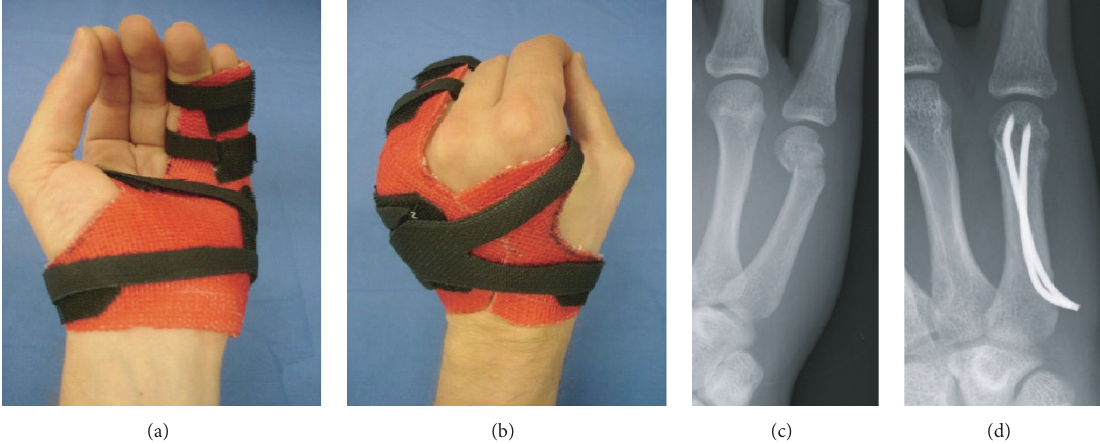
Figure 4: Middlehand orthoses (fingers included): (a) palmar and (b) dorsoradial view; case sample: angulated fracture of the 5th metacarpal head, (c) X-ray on admission and (d) at 6 weeks following anterograde nailing technique (2x intramedullary 2mm k-wire) (DASH analysis of case series: 𝑛 = 17 ; score-mean = 32.37 ± 2.53 SD; DASH follow-up interval (weeks): 11.68 ± 1.17